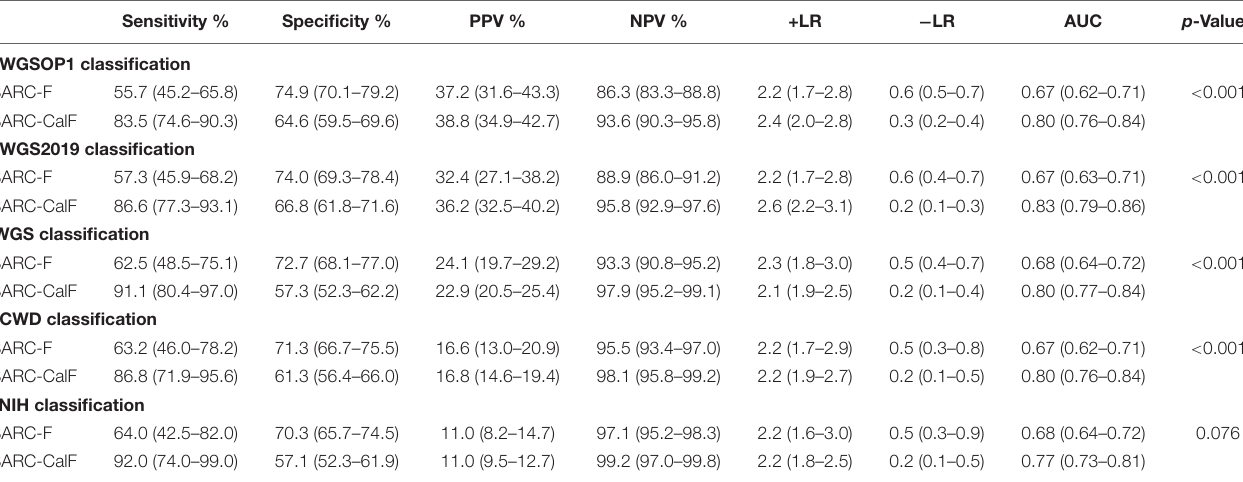
TABLE 4 | Sensitivity, specificity, PPV, NPV, +LR, and − LR analyses and ROC curves for SARC-F and SARC-CalF validation against different sarcopenia criteria in